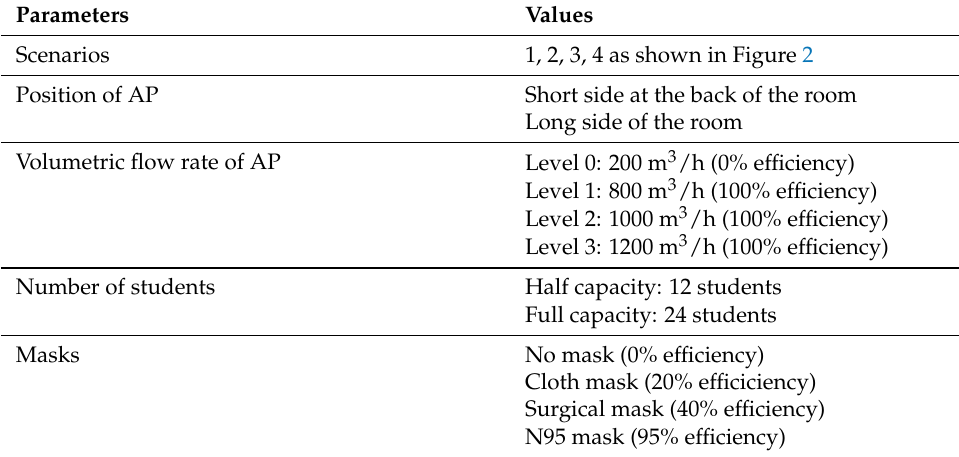
Table 1. Summary of parameters considered for